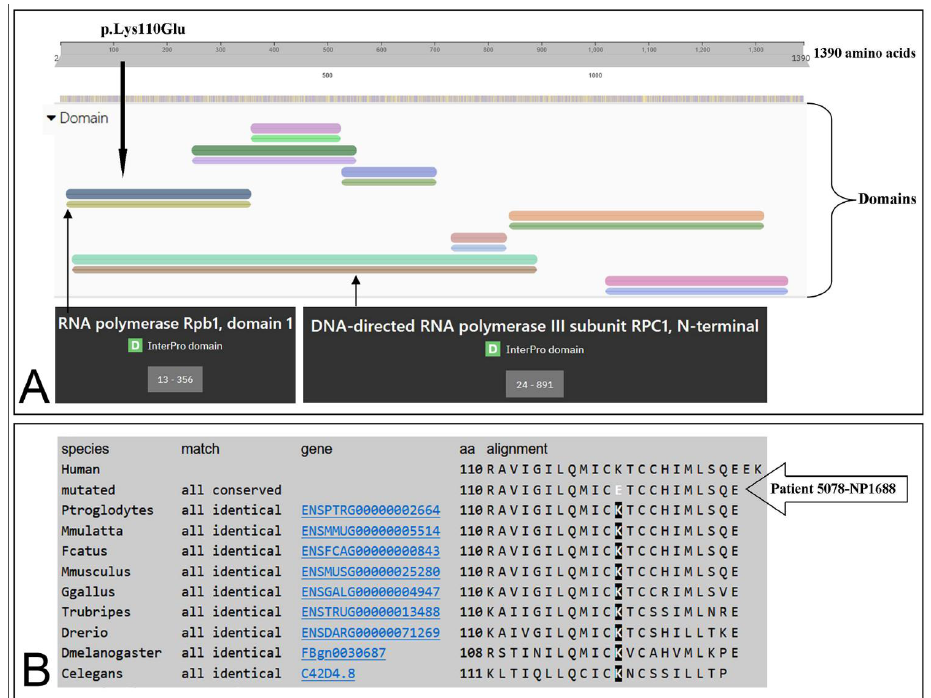
Figure 5. p.Lys110Glu domain position of POLR3A protein and sequence alignment. ( A ) Location of the p.Lys110Glu (black arrow) within RPC1 domain of the POLR3A protein (modified from InterPRO: https://www.ebi.ac.uk/interpro/protein/UniProt/O14802/, accessed on 6 September 2022). ( B ) Sequence alignment among multiple species showing that lysine (K) at position 110 is highly conserved, and mutated in the patient with leukodystrophy here analyzed (5078-NP1688) (modified from MutationTaster: www.mutationtaster.org/MT69/MutationTaster69.cgi, accessed on 6 September 2022).